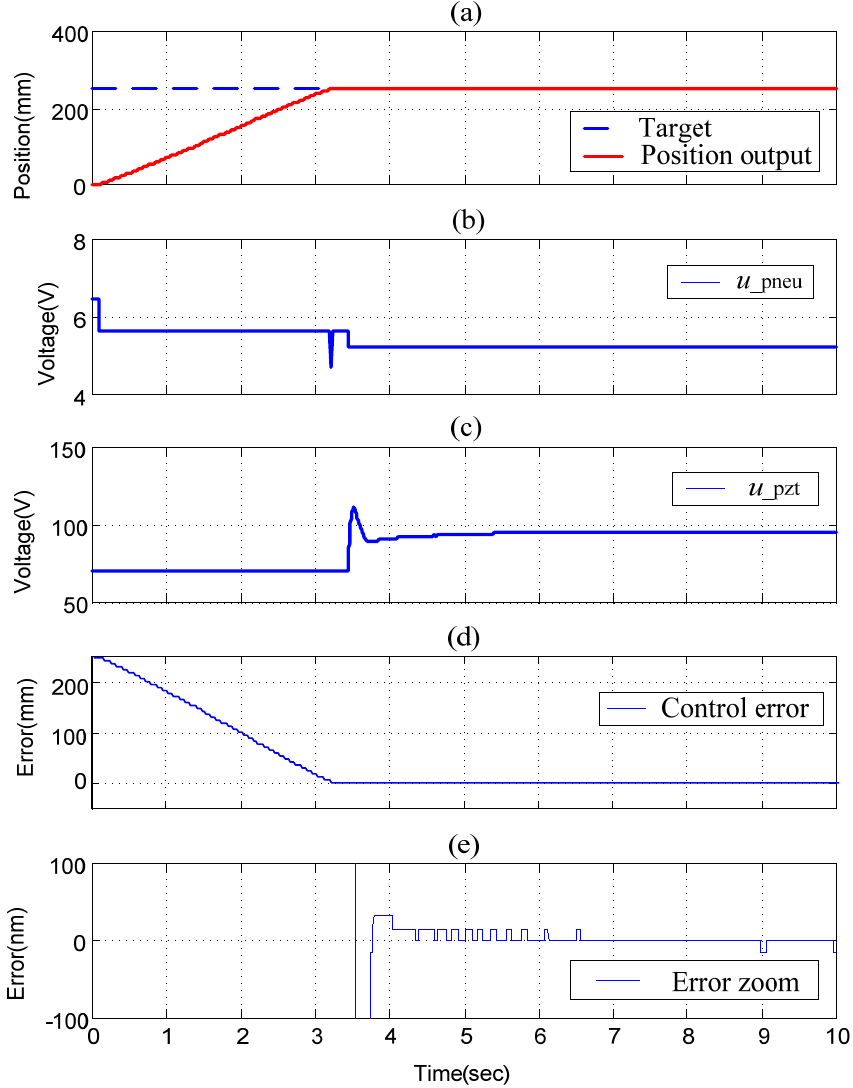
Figure 9. Experimental results of position control of pneumatic-piezoelectric hybrid actuator for single axis with stroke of 250 mm by DSOFSMC (with decoupling compensator): (a) position control response, (b) pneumatic control signal, (c) piezoelectric control signal, (d) position control error, (e) error